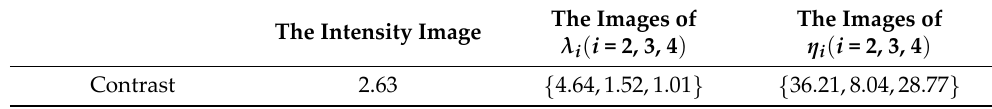
Table 3. The contrast of Figures